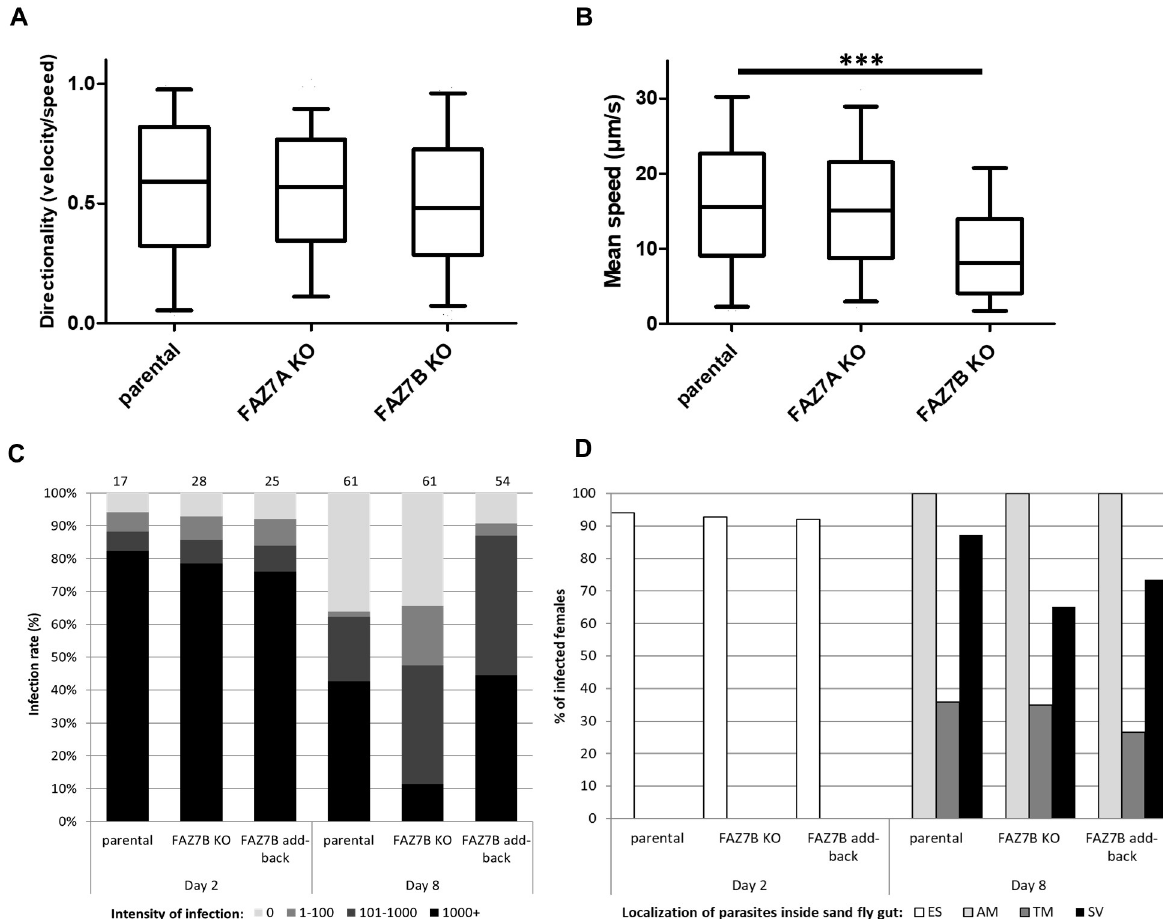
Fig 7. Deletion of FAZ7B impairs motility, proliferation and development of Leishmania in the sandfly. (A) Directionality (velocity/speed) and (B) swimming speed measurements of parental, FAZ7A KO and FAZ7B KO promastigotes were calculated from swimming tracks obtained from video microscopy using the plugin Trackmate. Boxes and error bars indicate the mean, upper and lower quartiles and 95th percentiles. ��� p < 0.001 (Student’s t -test). (C) Infection rate and intensity of infection in Lutzomyia longipalpis females infected with parental, FAZ7B KO and FAZ7B add-back cells. After 2 days and 8 days post-blood meal (PBM), sandflies were dissected (numbers indicated above the column) and the parasite load in each fly was measured as weak (1–100 parasites), moderate (101–1000 parasites), or heavy (1000+ parasites). The differences between the sandfly infections caused by parental and KO cell lines on day 8 PBM were highly significant (Chi-squared test, X 2 value: 22.237, p value: 7.02.E-7). (D) Localization of Leishmania parasites within infected sandflies after 2 days and 8 days PBM. ES: endoperitrophic space, AM: abdominal midgut, TM: thoracic midgut, SV: stomodeal valve. Differences were observed among infections caused by the three cell lines but were not found statistically significant.